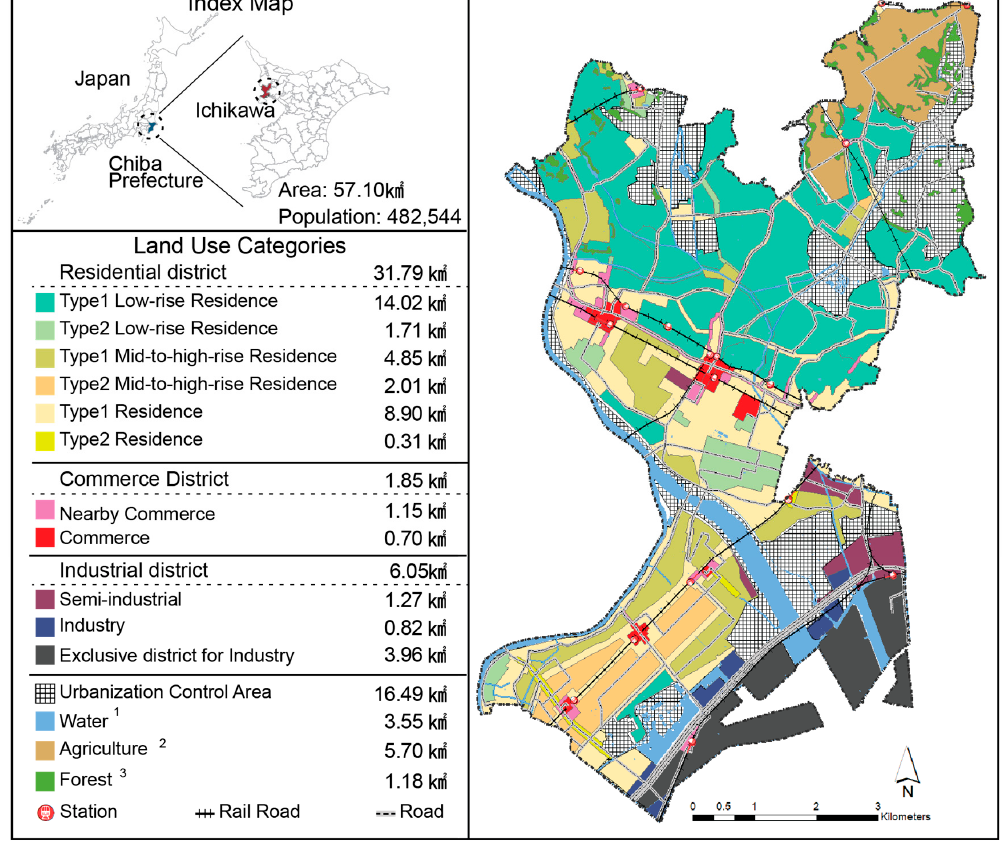
Figure 1. Location of and land use categories in Ichikawa, Japan. 1 Some of the total water areas overlap with urbanization control areas. 2 The agricultural district is included in the controlled urbanization district. 3 Forest area exists not only in agricultural districts, but also residence districts and controlled urbanization districts.